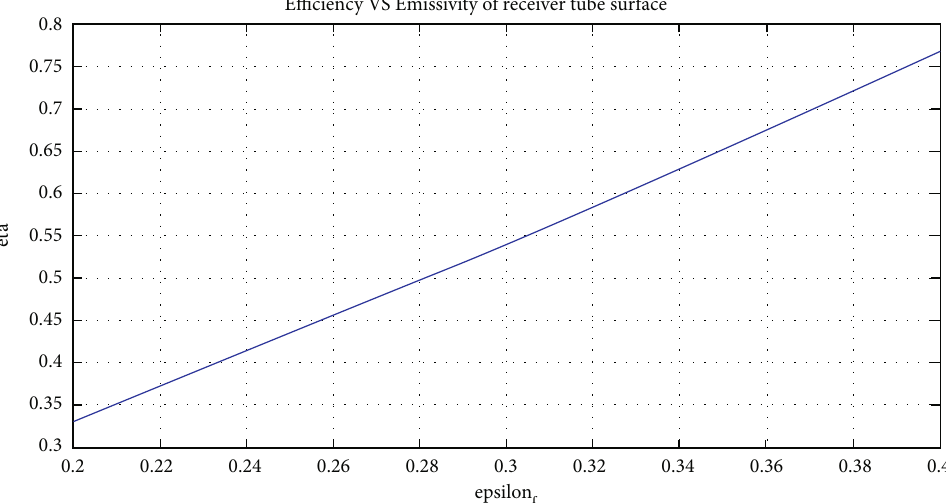
Figure 5: Changes in the e ffi ciency of the absorber pipe by its emissivity coe ffi cient.